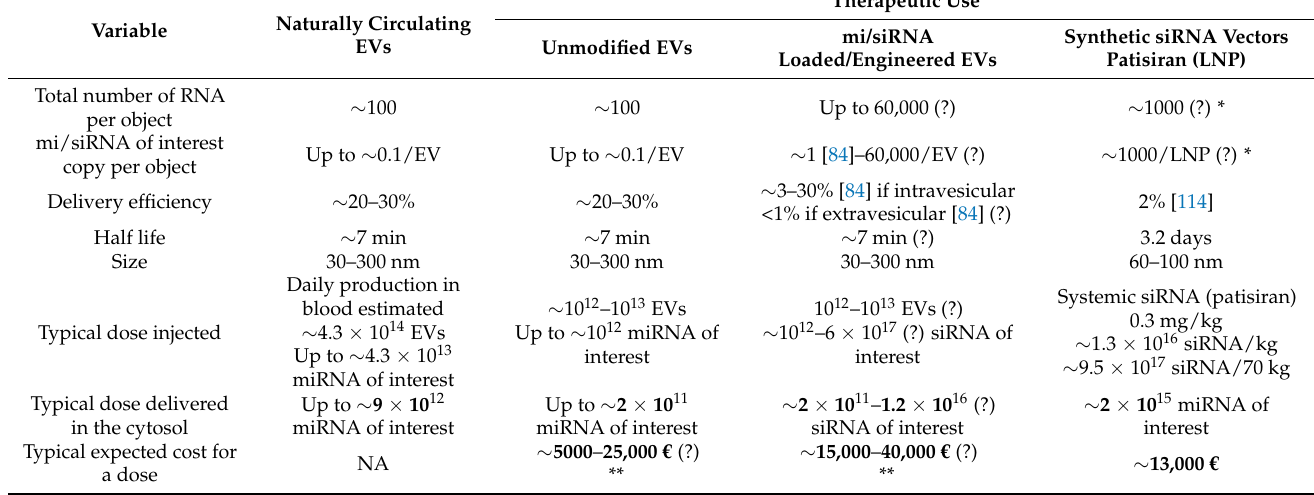
Table 3. Comparison of key pharmacokinetic and delivery parameters of EVs and synthetic vectors (lipid nanoparticles, LNP). Of note, (?) depicts a very discussed or uncertain parameter, (*) number of nanoparticle per object is based on the following assumptions: 10:1 lipid to siRNA ratio [113,114], mean nanoparticle size 80 nm. ** As no EV-based therapeutics are on the market, cost estimations intervals are based on discussions with industrials in the EV field, comparison based on production costs and expected production-cost/final-cost ratio in the biotherapy field and typical reimbursement obtained for biotherapies in Europe and